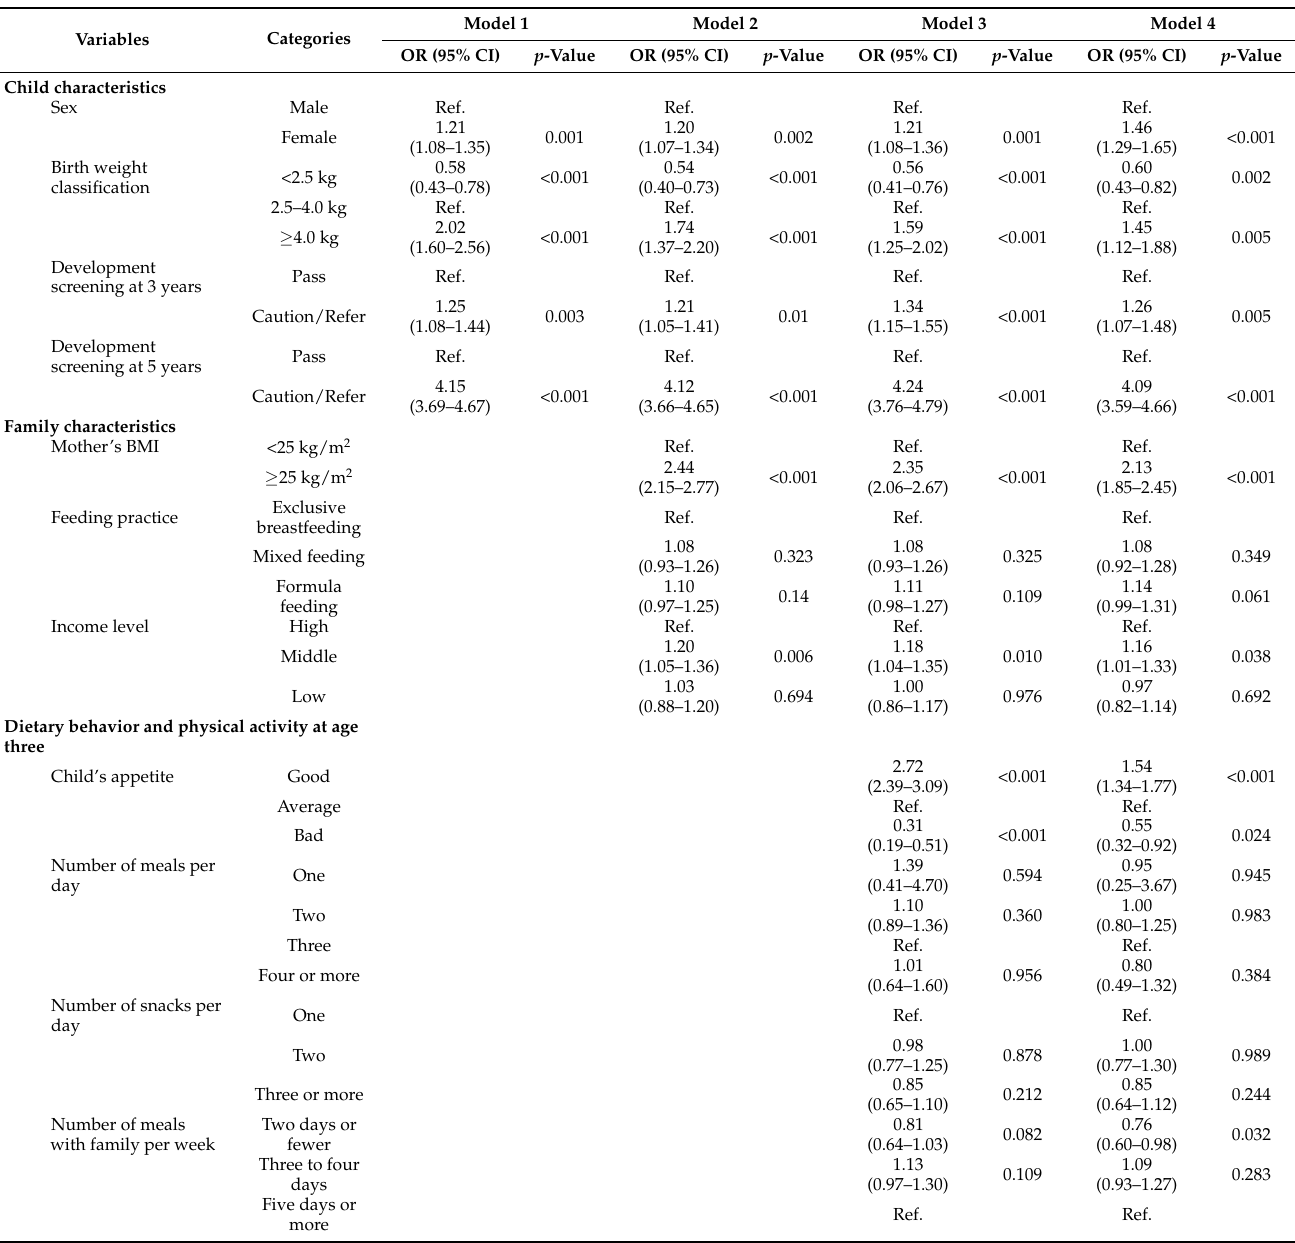
Table 3. Hierarchical multiple logistic regression analysis of obesity among subjects at age five ( n =